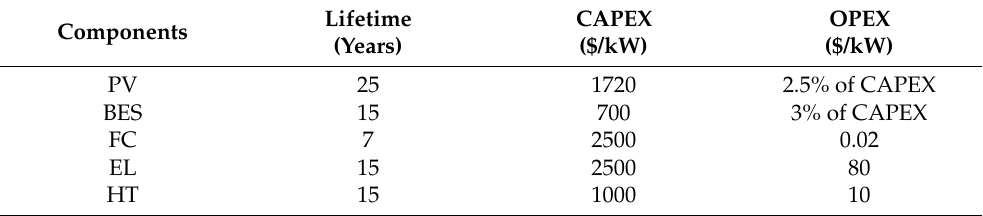
Figure 4. Proposed HES. Table 2. Capital (CAPEX) and operating and maintenance (OPEX) costs of different components.